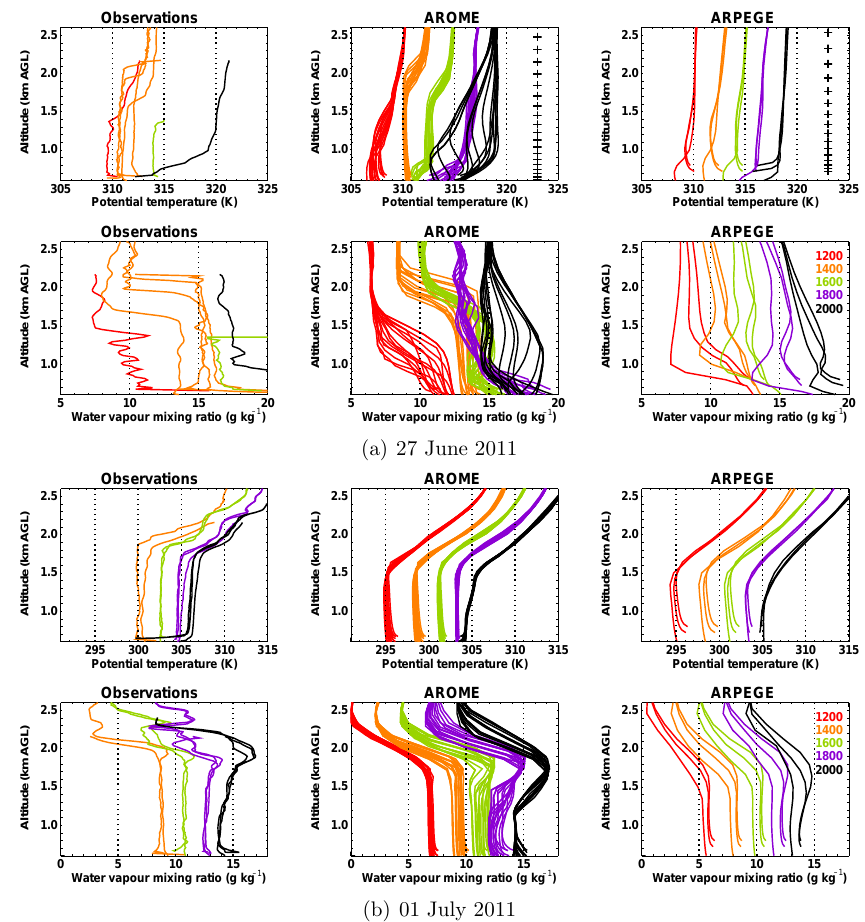
Figure 7. Vertical profiles of potential temperature and water vapour mixing ratio for observations (left panels), AROME (middle panels) and ARPEGE (right panels) for 2 days: 27 June 2011 (upper panels) and 1 July 2011 (lower panels). For visibility purposes, the vertical profiles are offset by adding 2K or 2gkg − 1 every 2h from 14:00 to